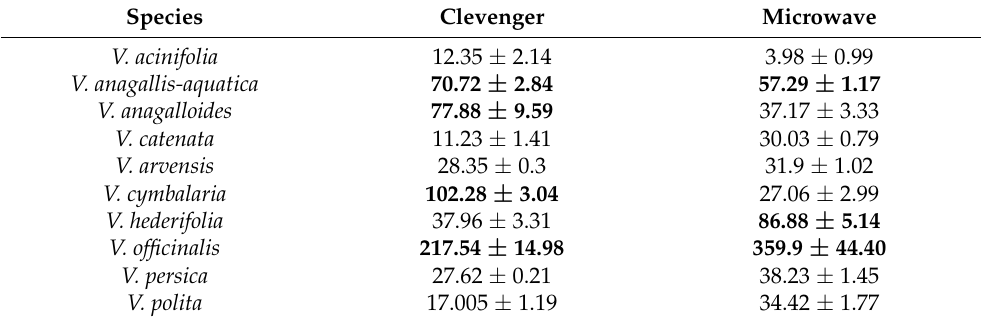
Figure 2. PCA analyses of volatile compounds of 10 Veronica species – hydrodistillation (HD) and microwave-assisted extraction (MAE). ( a ) PCA score plot for LLs and hydrosols (HY) from HD method; ( b ) PCA loading plots of volatiles from the first and second principal component for the LLs and hydrosols from HD method; ( c ) PCA score plot for LLs and hydrosols from MAE method; ( d ) PCA loading plots of volatiles from the first and second principal component for the LLs and hydrosols from the MAE method. Table 3. Antioxidant potential determined using the ORAC method of the hydrosols obtained by Clevenger and microwave-assisted extraction from the aerial parts of 10 Veronica